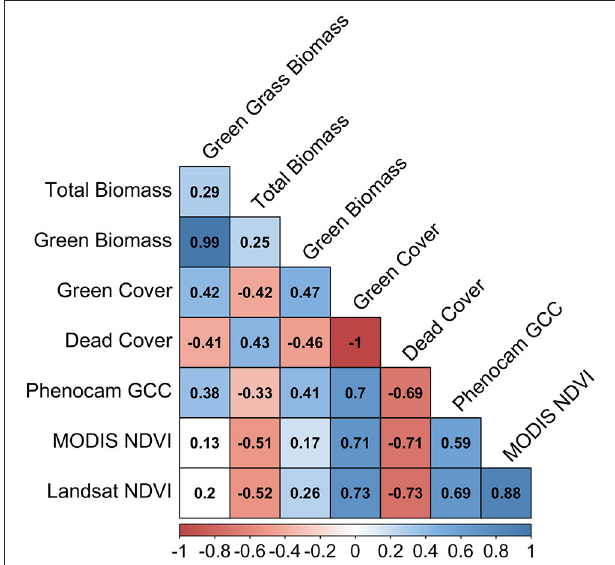
FIGURE 7 | Pearson’s correlation of variables across all sites that are relative to quality and quantity of green vegetation. Shaded values represent significant correlation at p = 0.05. Values are Pearson’s correlation coefficient ( r ). Negative values (red) indicate a negative correlation; positive values (blue) indicate a positive